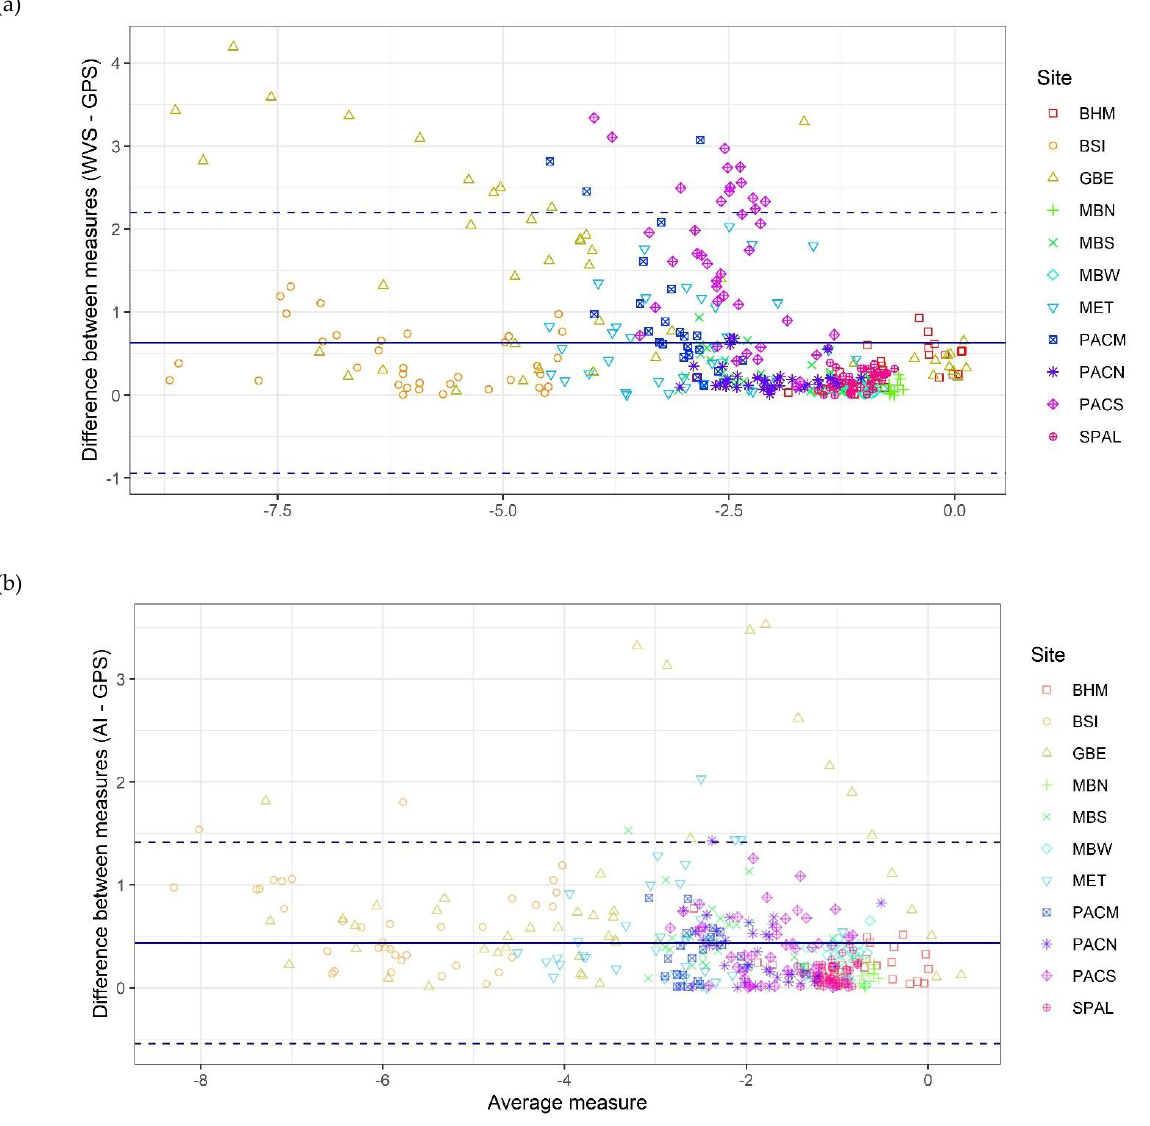
Figure 4. Bland–Altman plots showing the rate of shoreline change from Global Positioning System shorelines (GPSS) only versus shoreline change rates calculated from ( a ) WorldView-derived shorelines (WVS) exclusively and ( b ) aerial imagery-derived shorelines (AIS) exclusively. Solid blue line depicts the mean and blue dashed lines show the 95% confidence interval. The difference between 𝑏 𝑔 ̂ versus 𝑏 𝑤 ̂ and 𝑏 𝑎 ̂ provide an indication of the ability for each shoreline data source to accurately estimate shoreline change calculated from GPSS data (Figure 5b). The mean difference between 𝑏 𝑔 ̂ and 𝑏 𝑤 ̂ was 0.64 ± 0.09 and between 𝑏 𝑔 ̂ and 𝑏 𝑎 ̂ was 0.44 ± 0.05. The difference between 𝑏 𝑔 ̂ and 𝑏 𝑤 ̂ were lower than 𝑏 𝑎 ̂ at sites